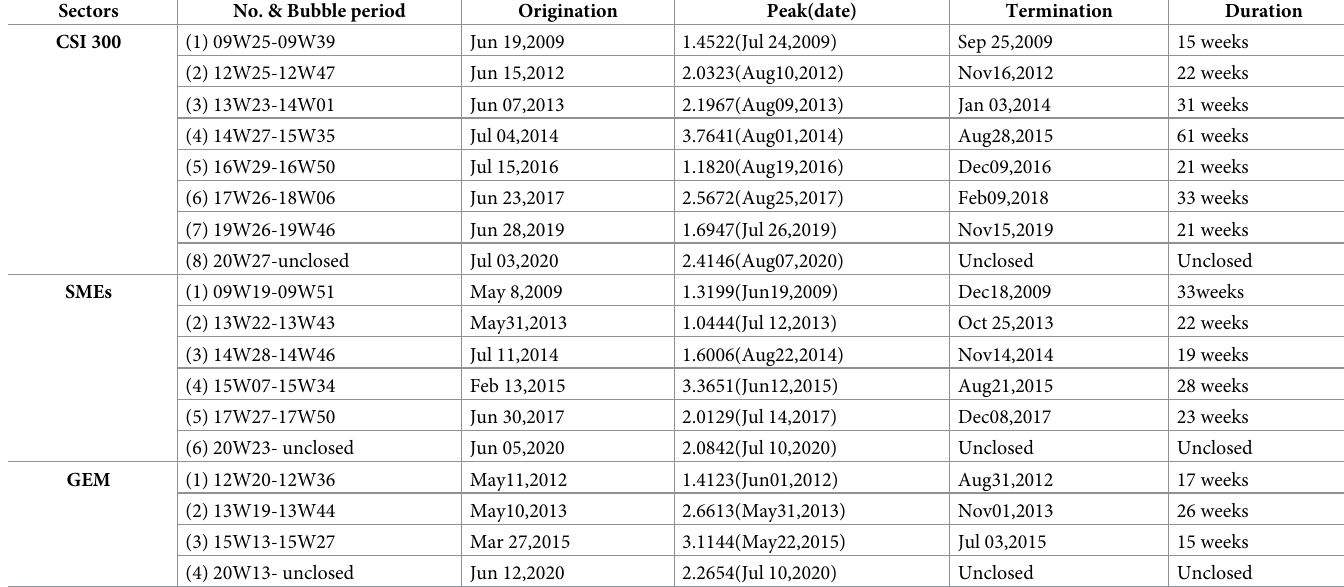
Table 2. The detailed bubble dating results of CSI 300, SMEs and GEM.